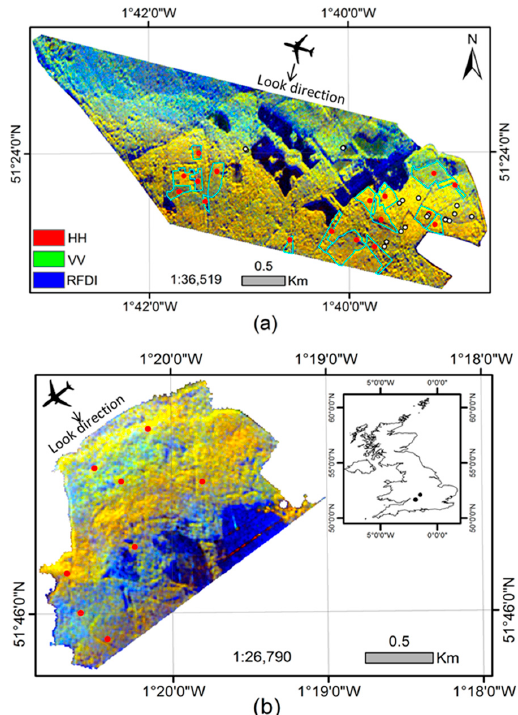
Figure 1. Fine resolution StripMap S-band data acquired over ( a ) Savernake and ( b ) Wytham in 2014 (False colour composite: red: HH, green: VV, blue: Radar Forest Degradation Index-RFDI) with sampled compartments (cyan polygon), training plots (red dot in both Savernake and Wytham) and validation plots (white with black border dot) (Savernake).